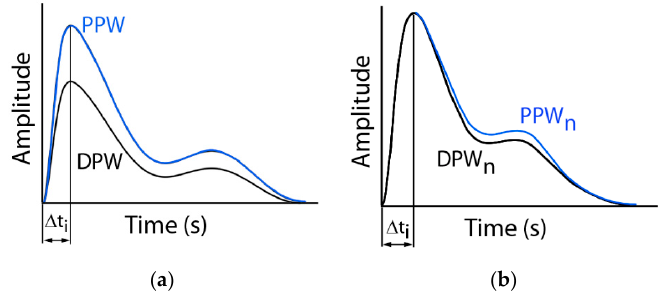
Figure 3. ( a ) PPW and DPW trajectories; ( b ) normalized PPW n = PPW/max(PPW) and DPW n = DPW/max(DPW) trajectories